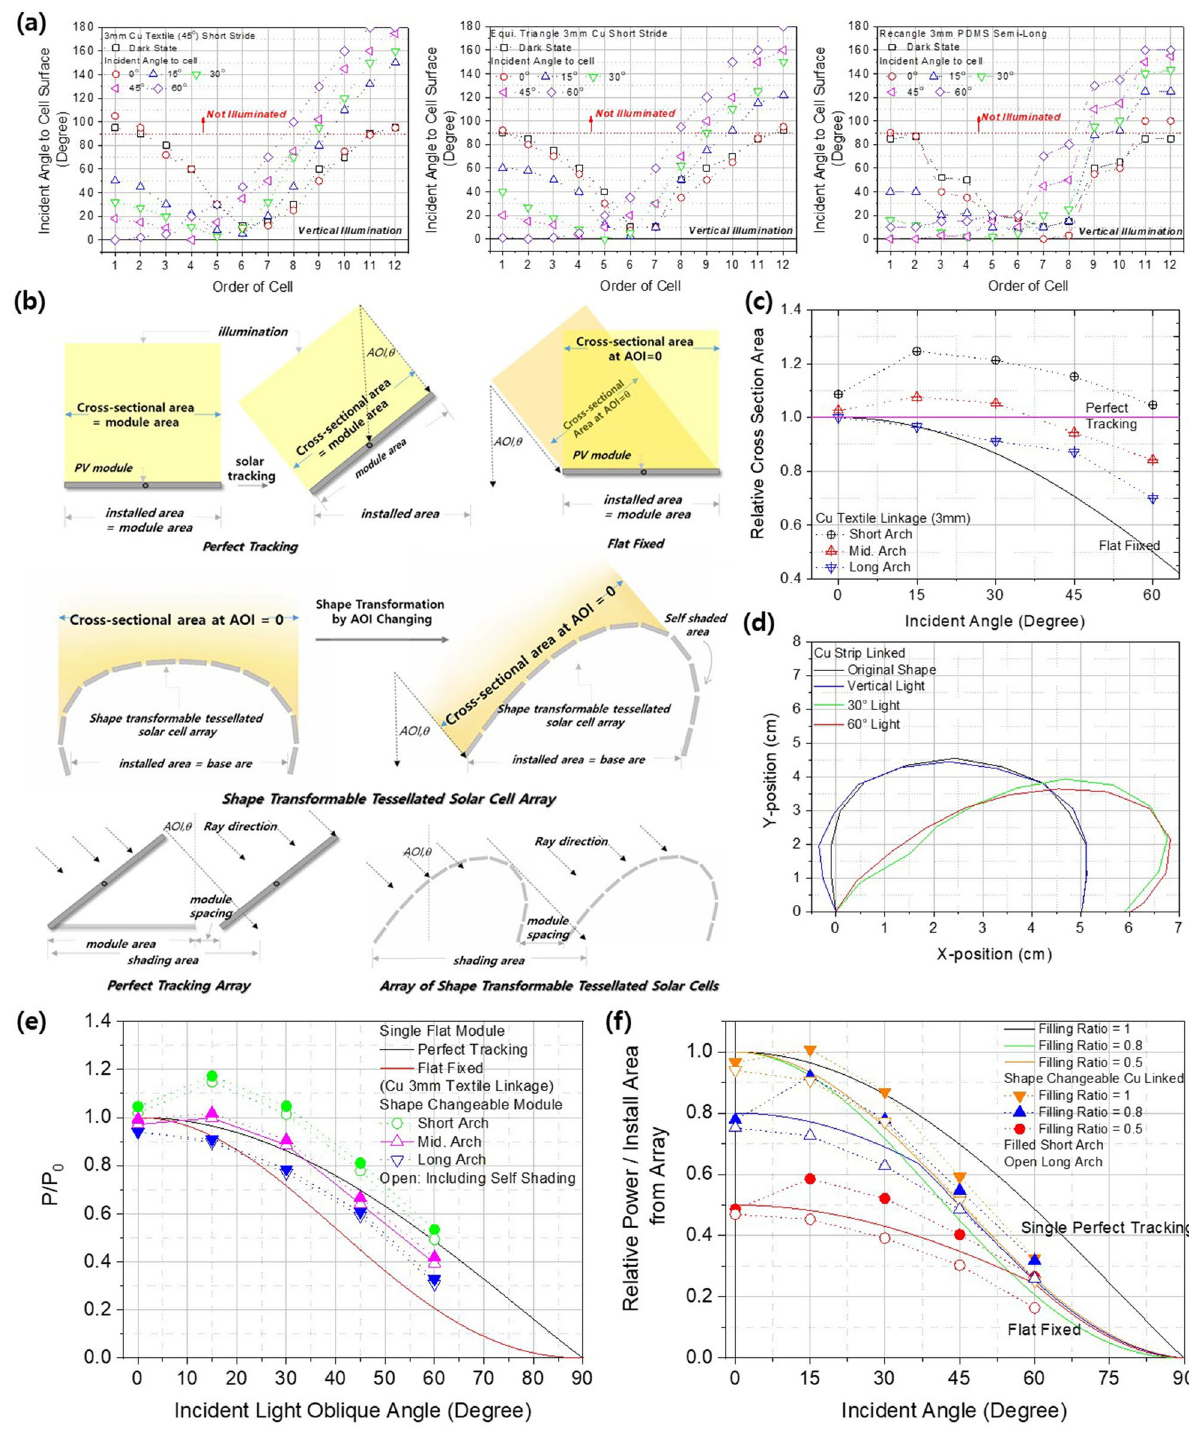
Figure 4. ( a ) Solar-tracking performance of a 2D tessellated solar-cell array according to the AOI and type of backbone. Illustration ( b ) and simulated values ( c ) comparing cross-sectional areas of a fixed flat perfect- tracking system and transformation of the arch-shaped tessellated solar cell array depending on AOI. ( d ) Actual arch geometry simulation results according to the AOI. ( e ) Simulation power-production results comparing a perfect tracking system and the transforming 2D arch-shaped tessellated solar cell array according to the AOI and ( f ) the interval between